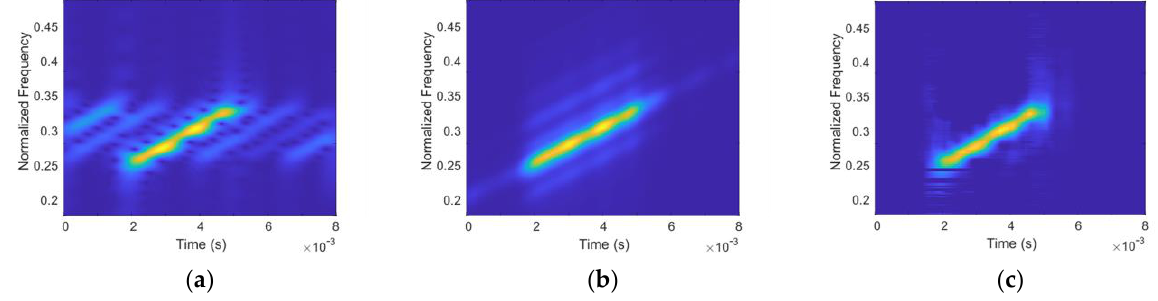
Figure 6. Reverberation suppression results for the signal with one highlight: ( a ) input signal; ( b ) output of the NMF method; ( c ) output of ACANet.